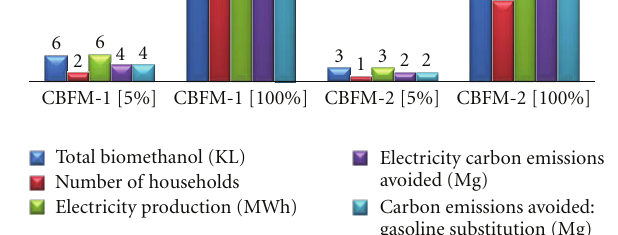
Figure 4: The amount of biomethanol produced and the amount of fossil-resource-derived electricity and gasoline, this amount can potentially replace and avoid carbon emissions when converting 5% or 100% of the annually available biomass collected from certified community managed production forests